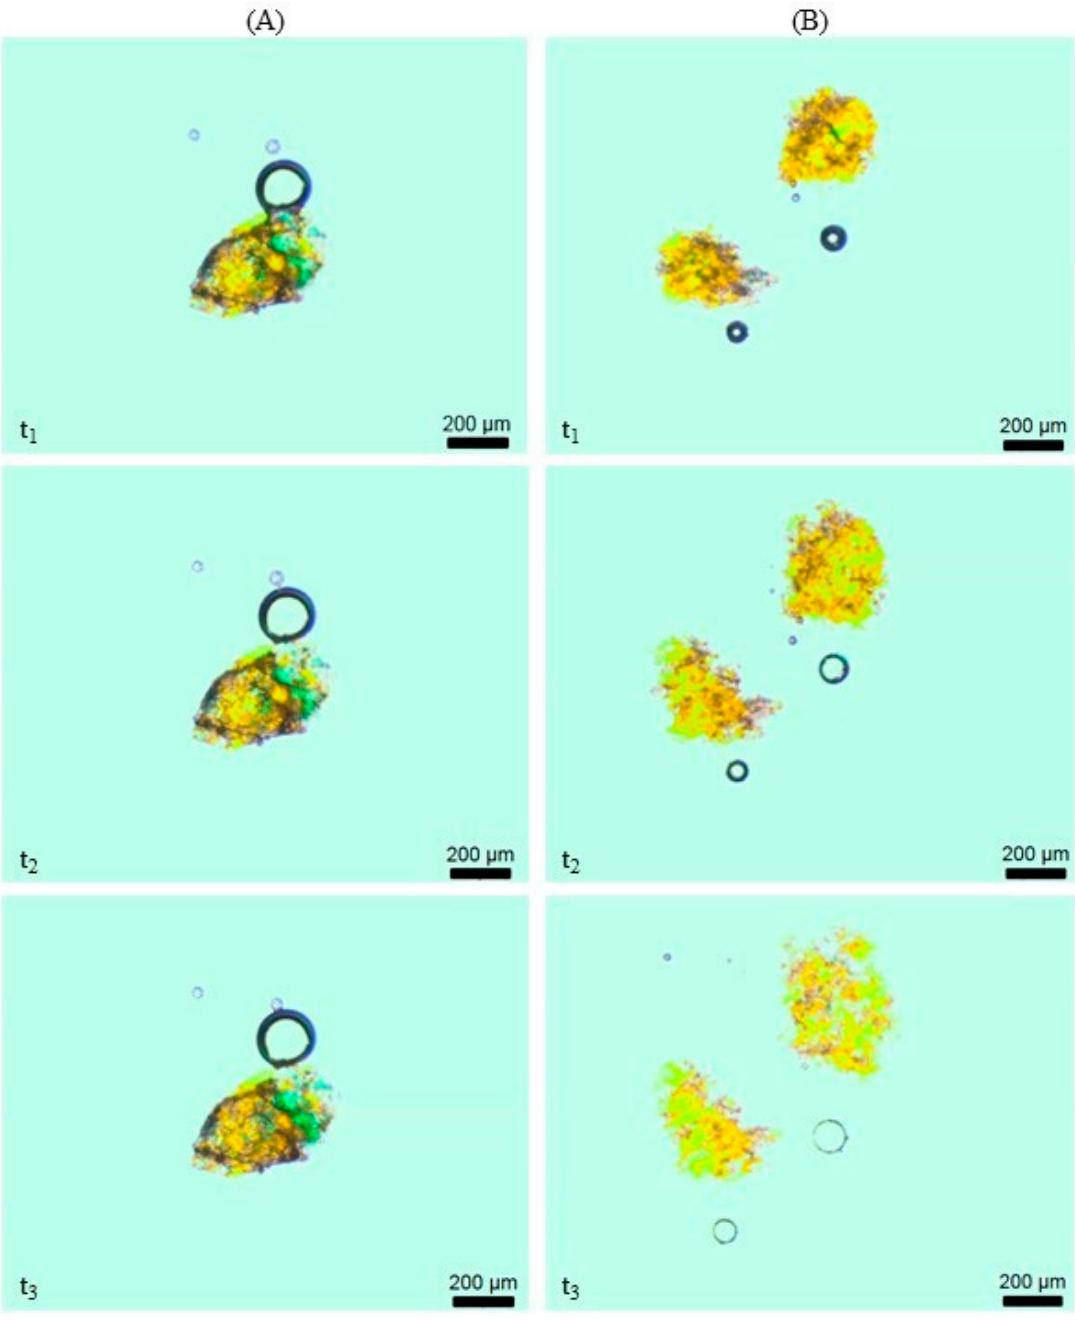
Figure 6. Swelling of particles: Raw material ( A ) and extruded sample ( B ) (W H2O = 17%) at time t 1 = 0 min, t 2 = 30 s, and t 3 = 30